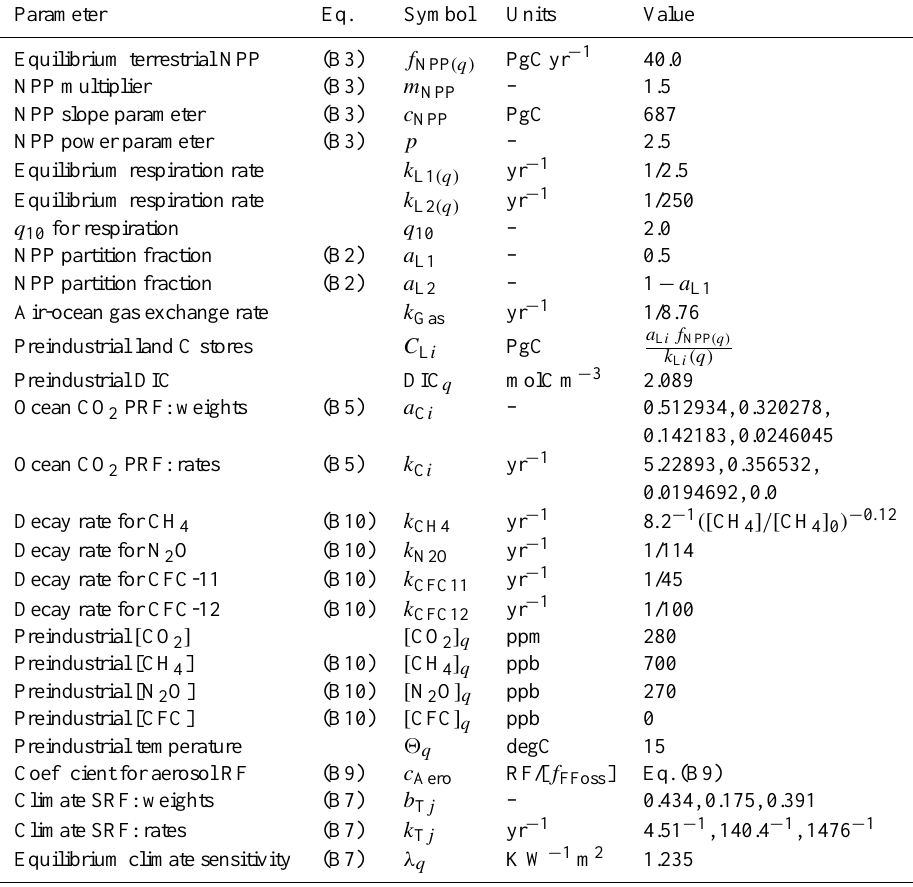
Table B1. Parameters in SCCM (see Appendix B for sources) . Parameter